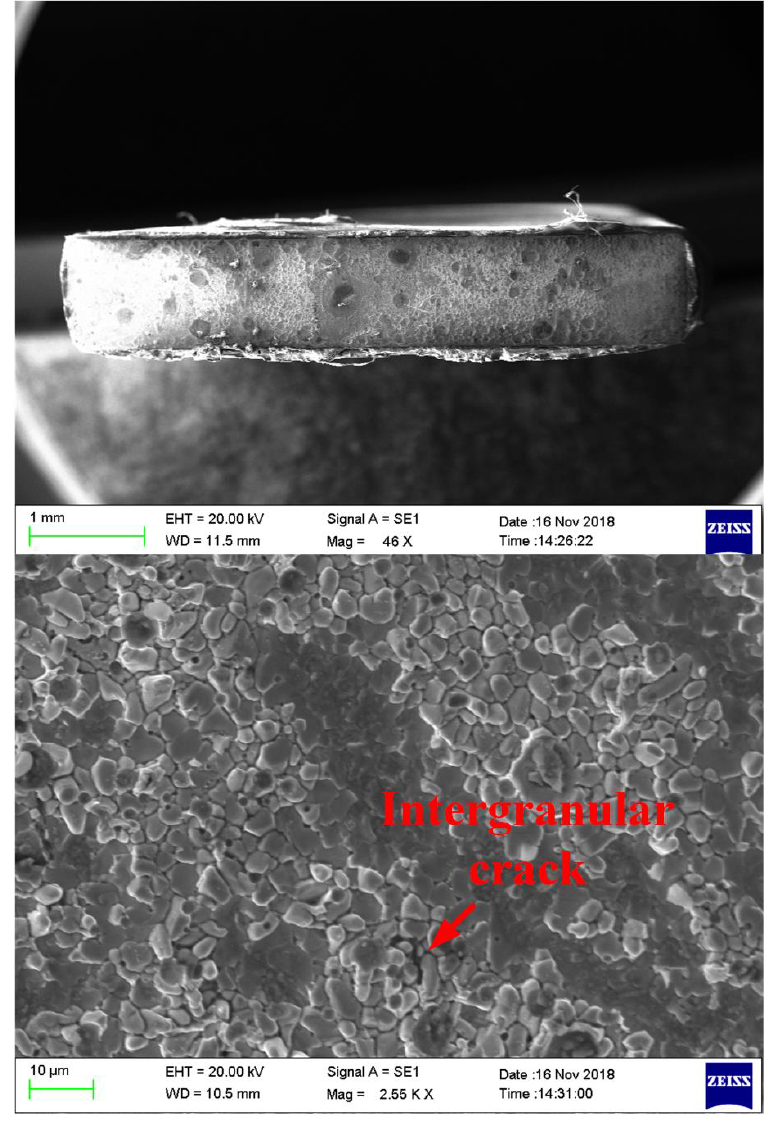
Figure 15. SEM graph of fracture surface at − 80 °C (brittle).